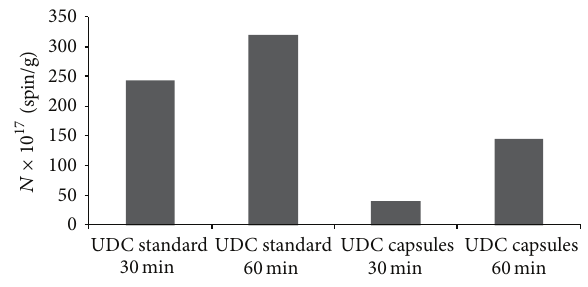
Figure 5: Comparison of free radical concentrations (𝑁) in the UV irradiated ursodeoxycholic acid (reference standard and tablets containing UDC) during 30 and 60